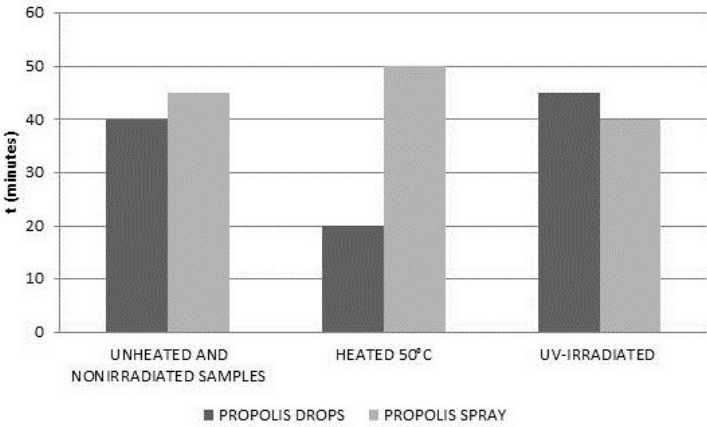
Figure 8. Comparison of the stabilization times (t) (±5 min) of DPPH interactions with drops and spray containing propolis for: the unheated and non-irradiated samples, the heated samples, and the UV- irradiated samples.